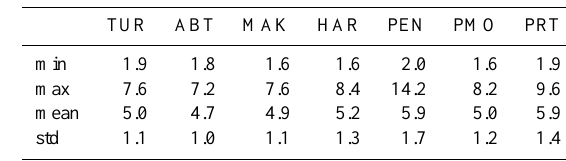
Table 4. Minimum (min), maximum (max), mean values (mean) and standard deviations (std) of PET model results for the study